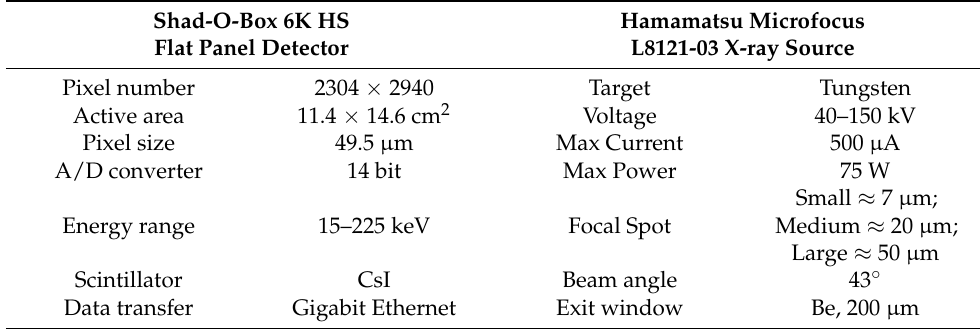
Table 1. Technical specifications of the equipment